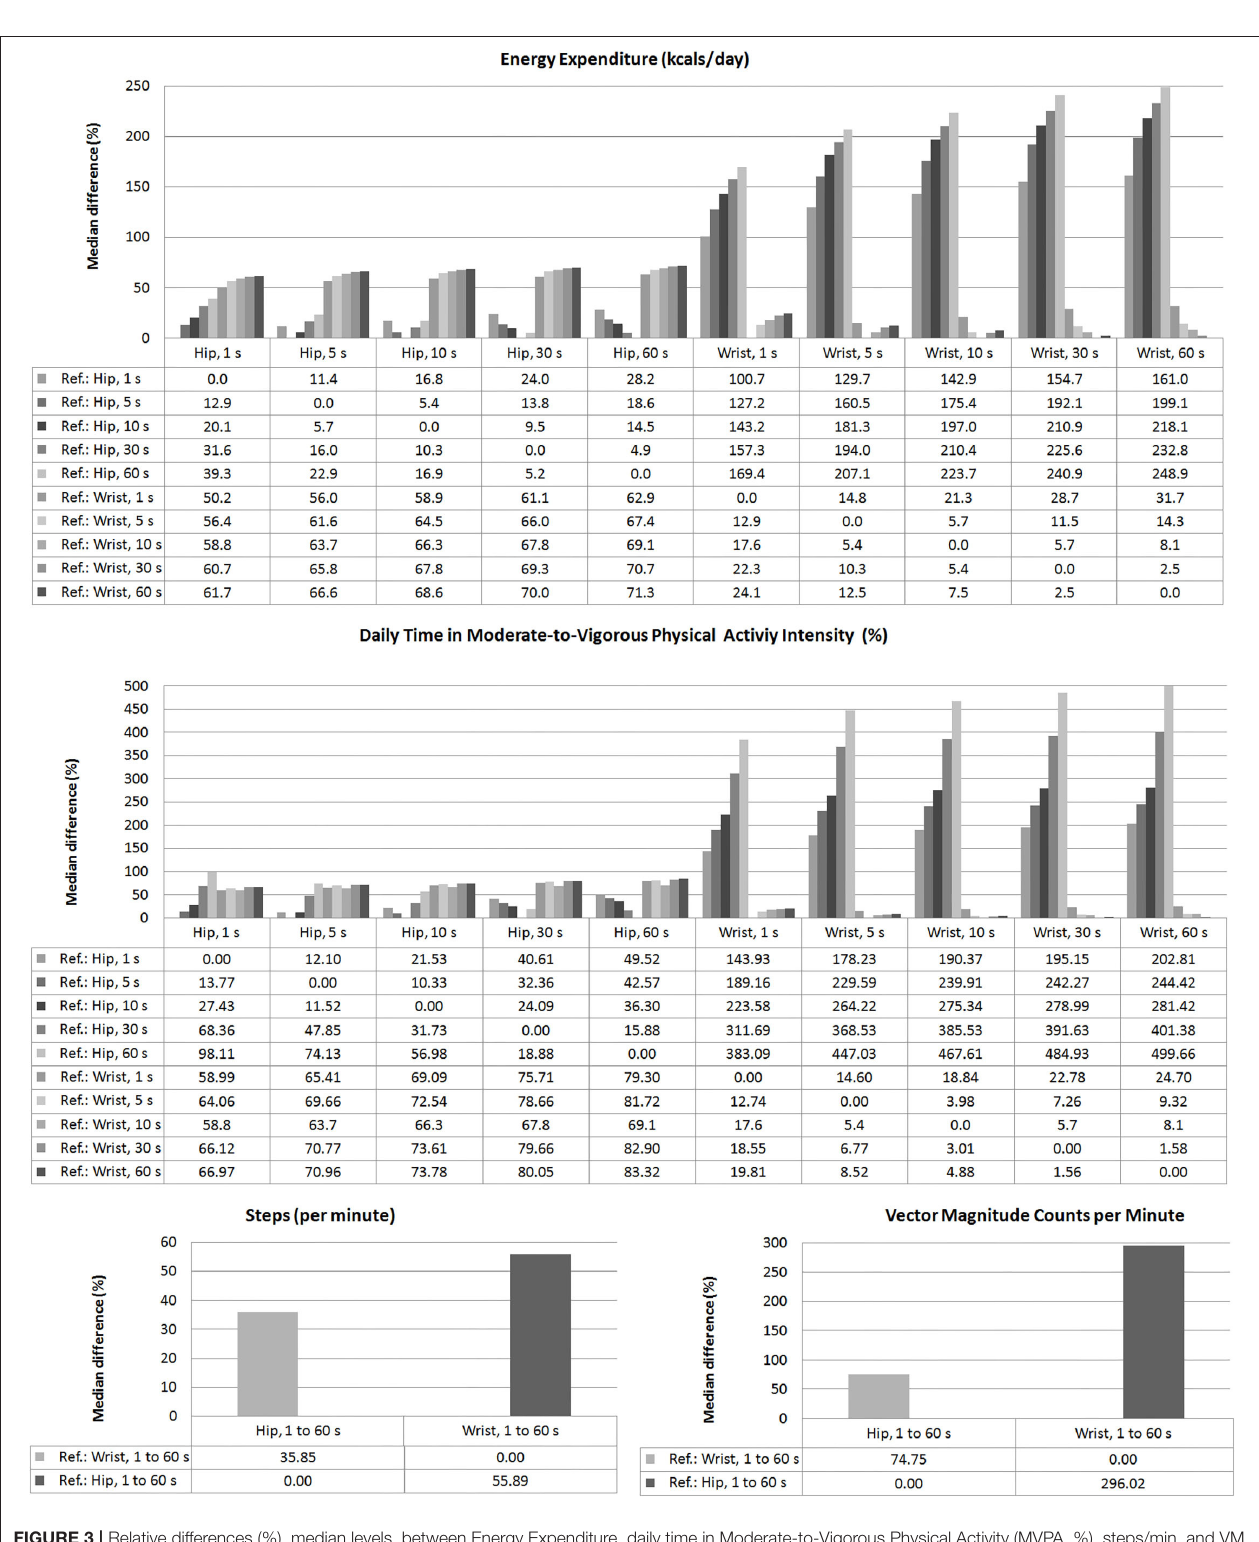
FIGURE 3 | Relative differences (%), median levels, between Energy Expenditure, daily time in Moderate-to-Vigorous Physical Activity (MVPA, %), steps/min, and VM CPM found depending on the registration site (hip or wrist) and the epoch length: 1, 5, 10, 30, and 60s. Levels of statistical significance ( p -values) for each paired comparison are detailed in Supplementary Tables 15 – 18 in Supplementary Material 2